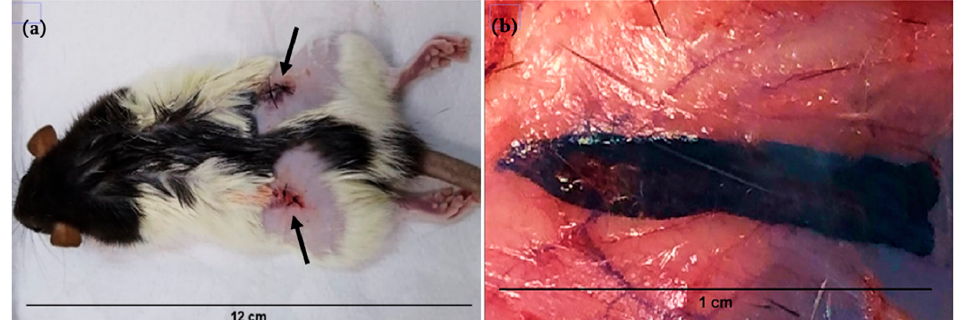
Figure 2. Surgical wound (arrows) after GO powder implantation in the subcutaneous tissue ( a ). 21 days evaluation of implanted biomaterial. GO ribbon agglutination form ( b ).